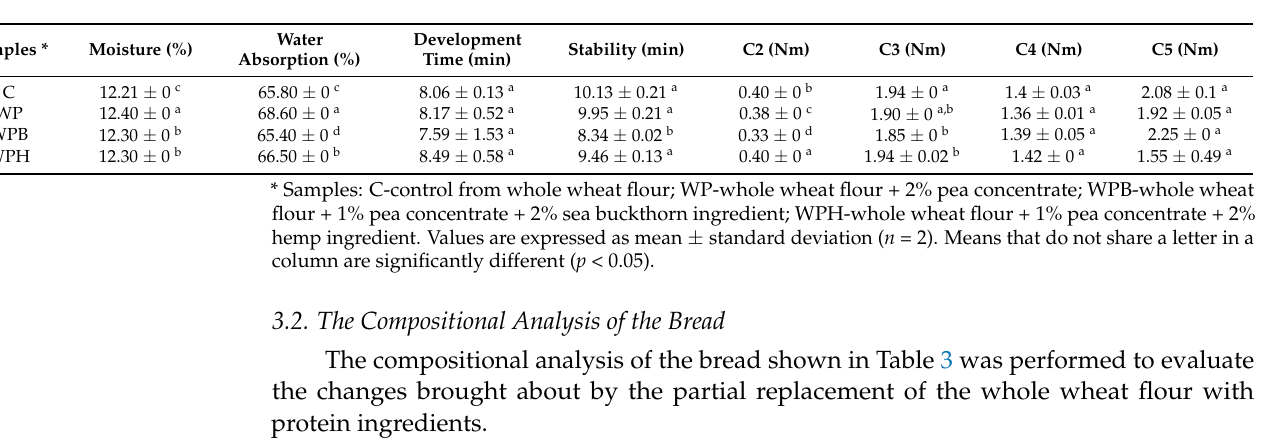
Table 2. Rheological analysis of flour mixtures with different percentages of protein